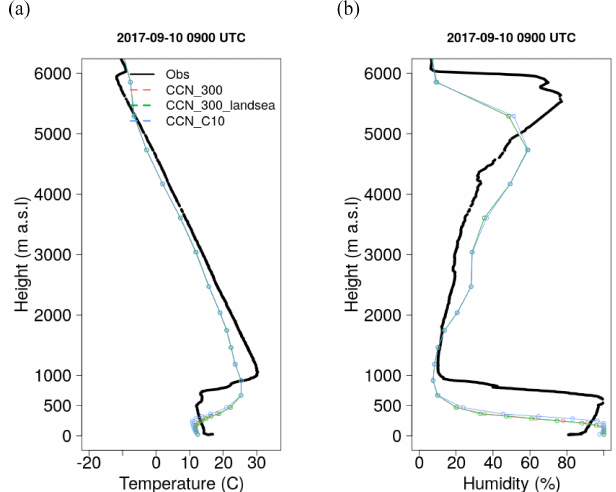
Figure 9. Radiosonde profiles of (a) temperature and (b) relative humidity from Jakkalsputz on 10 September 2017. The sonde was launched at 09:10UTC, and the model is from